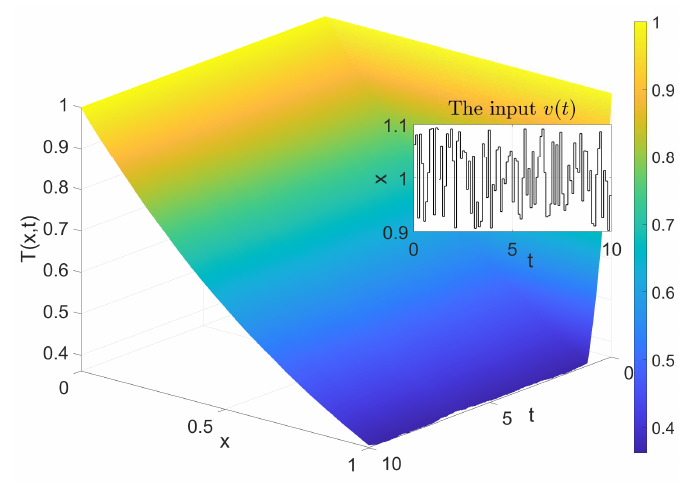
Figure 6. The curve of the output response T ( x , t ) and fluid velocity v ( t ) at v ( t ) ∼ O ( 1 )